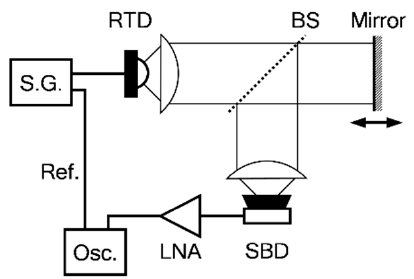
Figure 4. Schematic of the experimental setup.